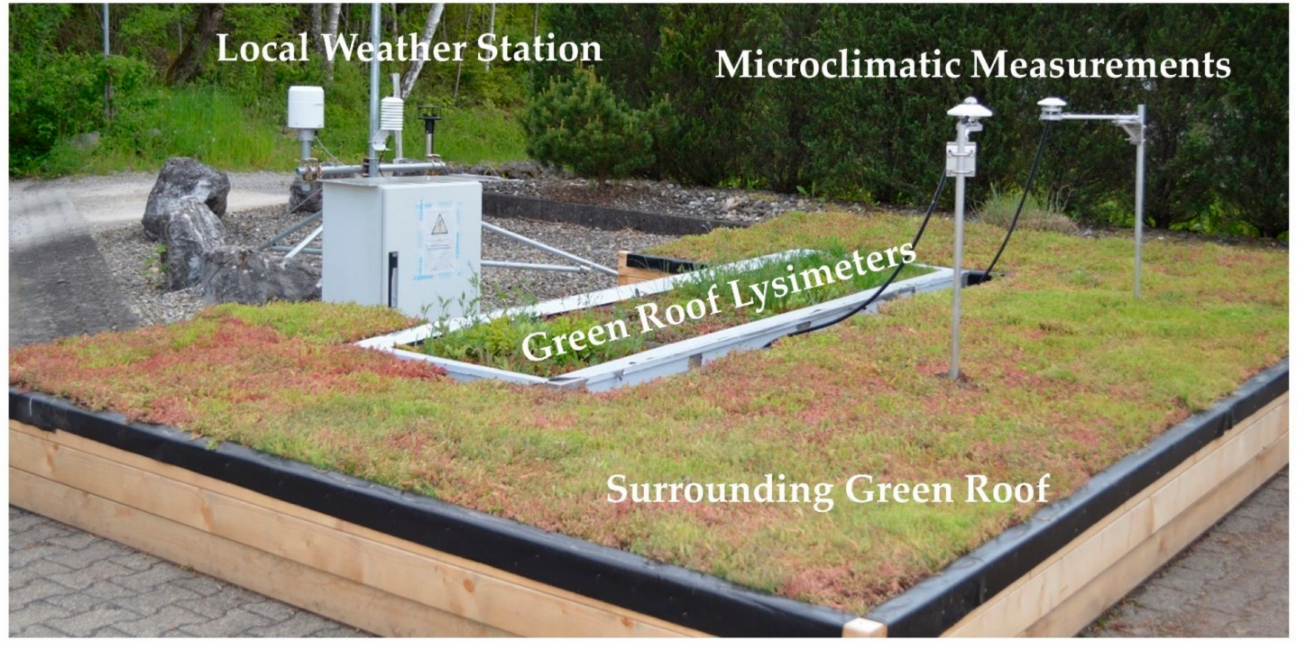
Figure 1. Experimental setup in Göggingen-Krauchenwies, Germany (48 ◦ 0 (cid:48) 20.27916 (cid:48)(cid:48) N, 9 ◦ 12 (cid:48) 5.33952 (cid:48)(cid:48)